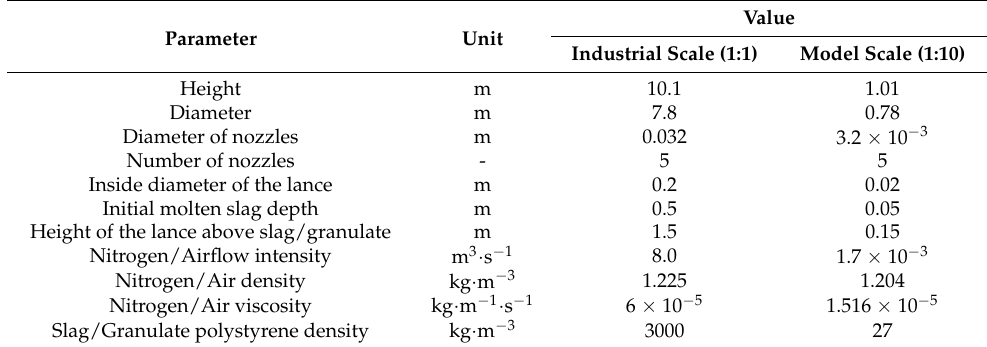
Table 3. Experiment parameters for the physical